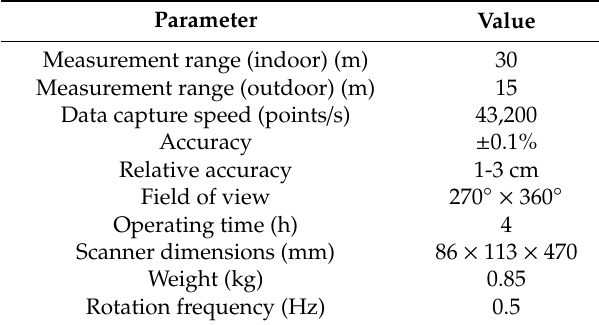
Table 1. Technical features of the PMMS,